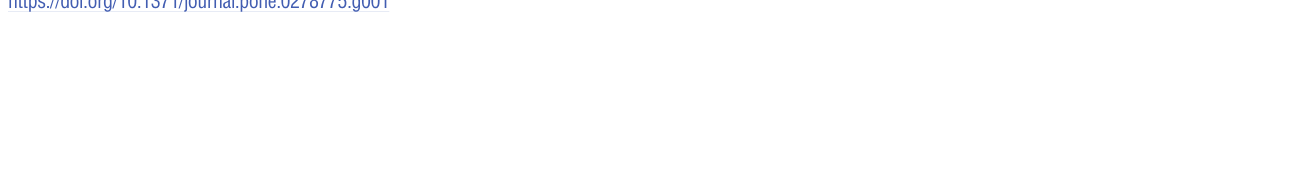
PLOS ONE | https://doi.org/10.1371/journal.pone.0278775 February 24,